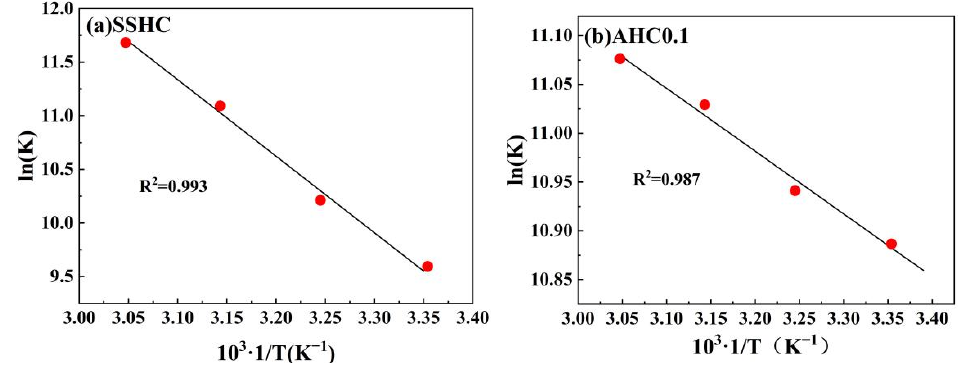
Figure 11. Linear regressions of van’t Hoff plot. Table 8. Parameters of adsorption thermodynamics.